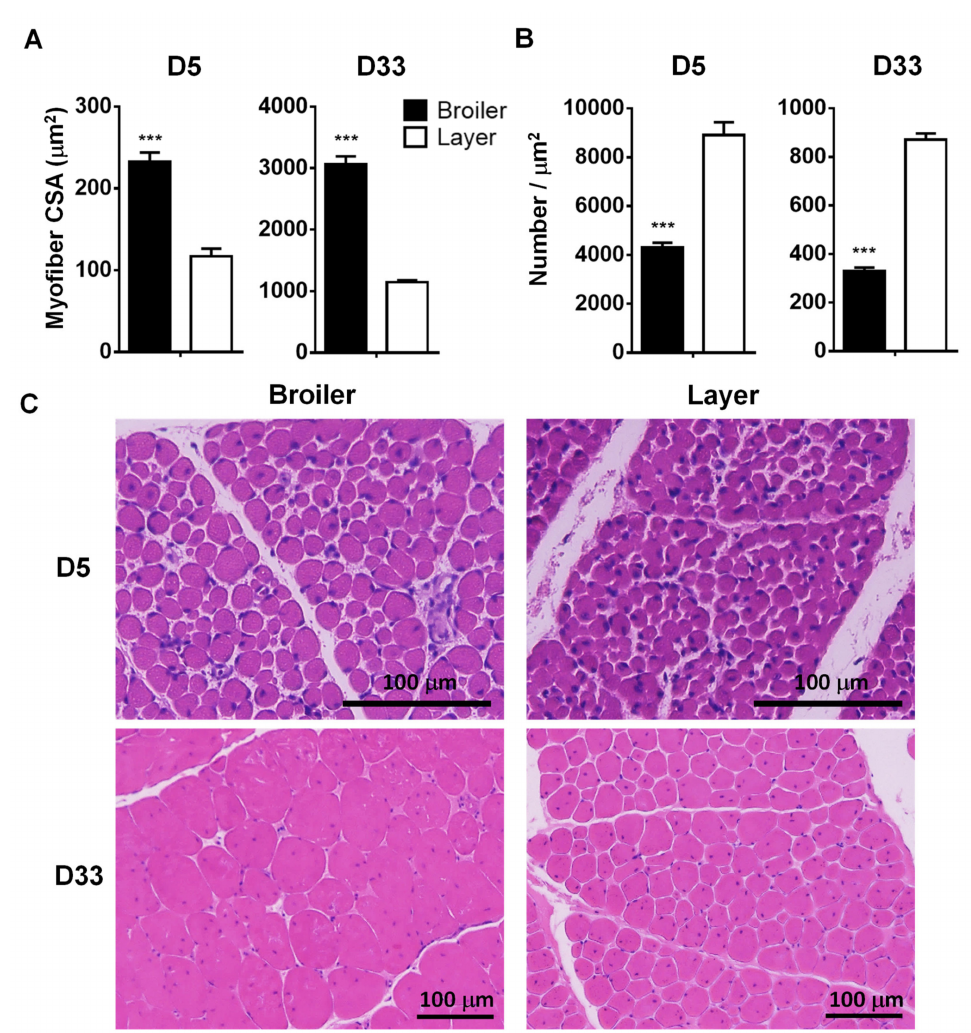
Figure 2. Morphological differences in pectoralis major muscles at D5 and D33 between 2